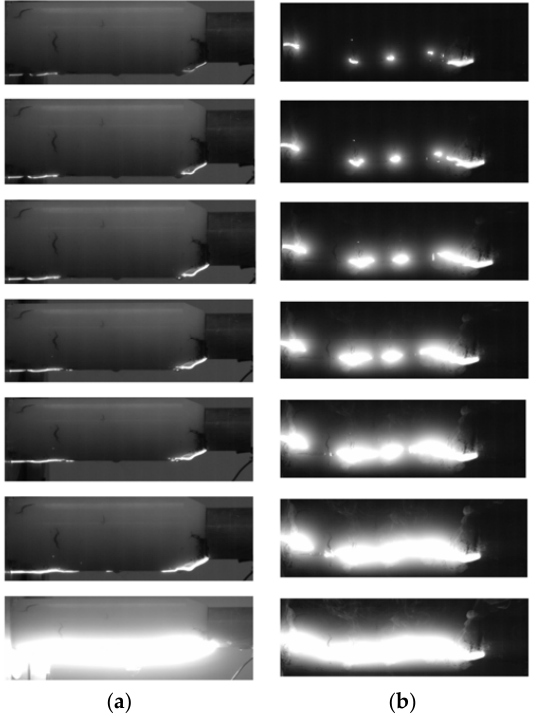
Figure 4. Arc propagation on sample A ( a ) Sliding flashover with a time interval of 660 μ s ( b ) Pollution flashover with a time interval of 330 μ s.